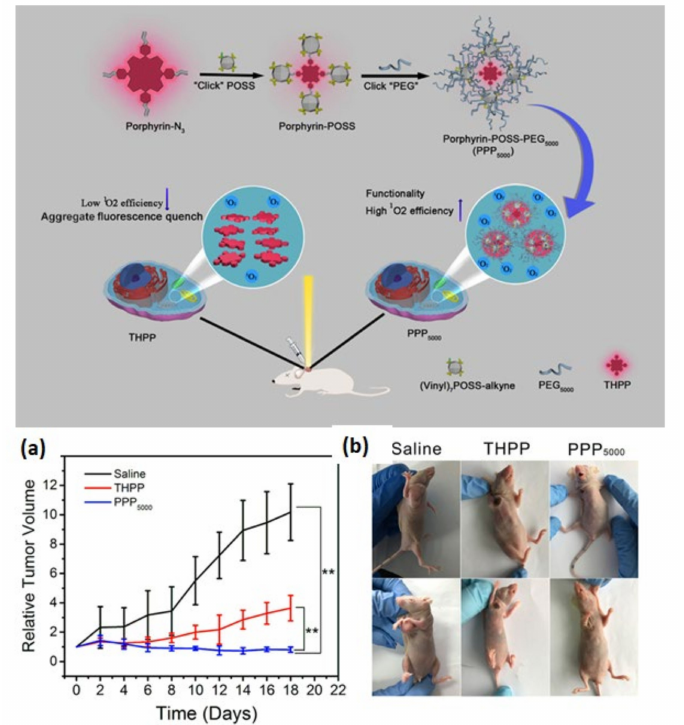
Figure 8. Schematic illustration of the fabrication process and photodynamic therapy of PPP5000 and THPP. ( a ) Changes of relative tumor volume (V/V 0 ) after mice were treated with saline, THPP, and PPP5000. Differences between groups were tested using one-way ANOVA. ** p ≤ 0.01. ( b ) Representative photos of mice after treatment. Reprinted with permission from ref. [49]. Copyright 2018 American Chemical